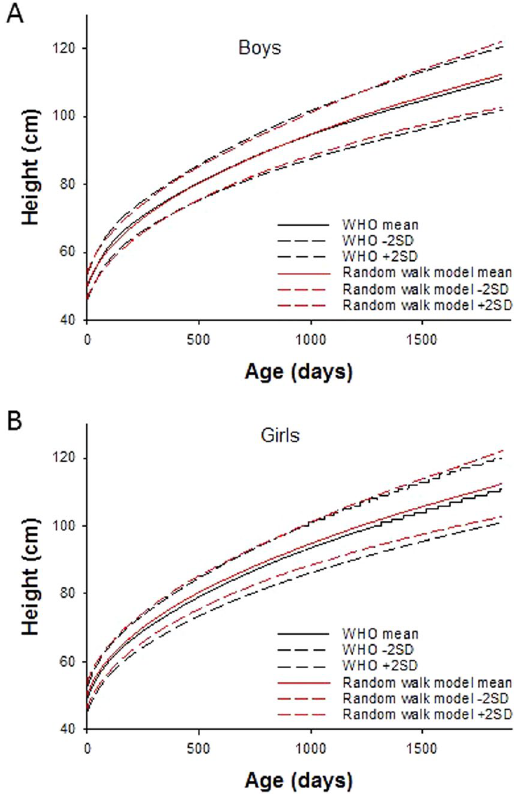
Figure 3. Simulated means and 2SDs of growth curves in comparison with the WHO training data set for boys ( A ) and girls ( B ).